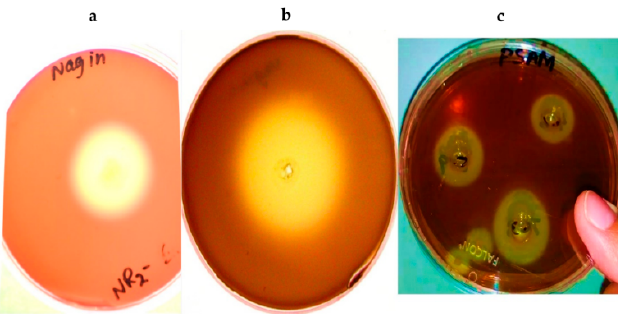
Figure 1. ( a ) Screening of pectinolytic B. subtilis isolate using PSAM (pectinase screening agar medium) containing 0.5% citrus pectin from Sigma. After inoculation, the plate was incubated overnight at 37 ◦ C, flooded with 0.5 mM iodine solution for 20 min, and rinsed with water; ( b ) Selected colony based on the large halo of pectin depolymerization; ( c ) well plate assay of endoPGase enzyme on PSAM.